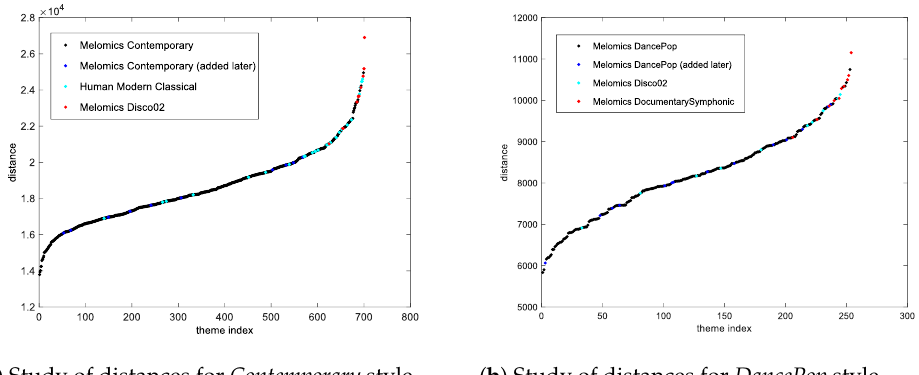
Figure 7. Chart ( a ) shows a representation of the distances to the centroid of Melomics’s Contemporary style from themes of other styles configured with Melomics and a collection of themes composed by human artists from the Bodhidharma dataset. Chart ( b ) shows the distances to the centroid of Melomics’s DancePop style from themes of different styles configured with Melomics tonal